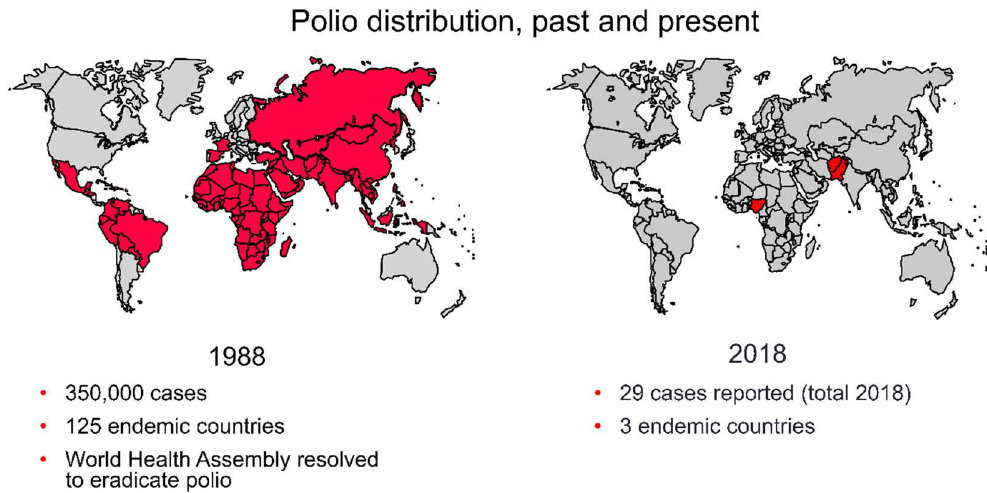
Fig. 1. Map of polio distribution, past and